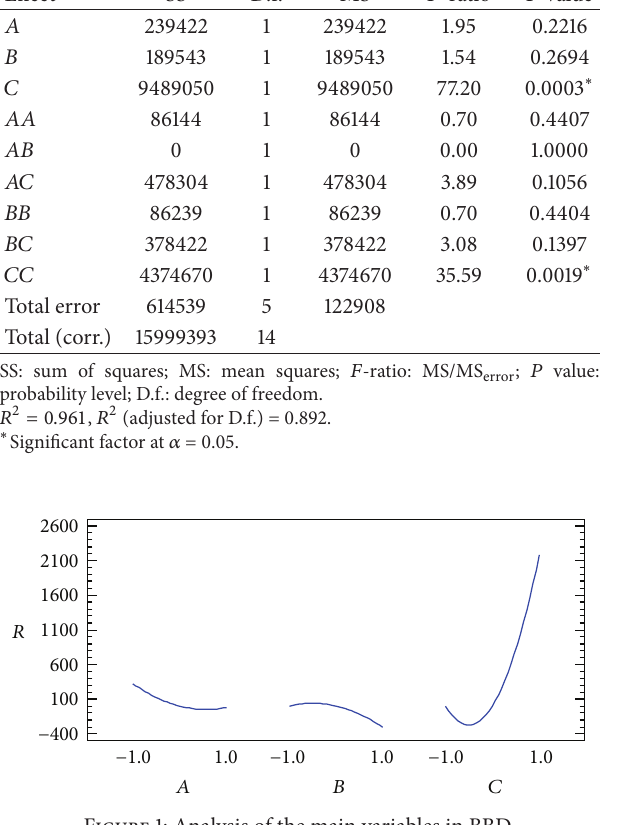
Figure 1: Analysis of the main variables in